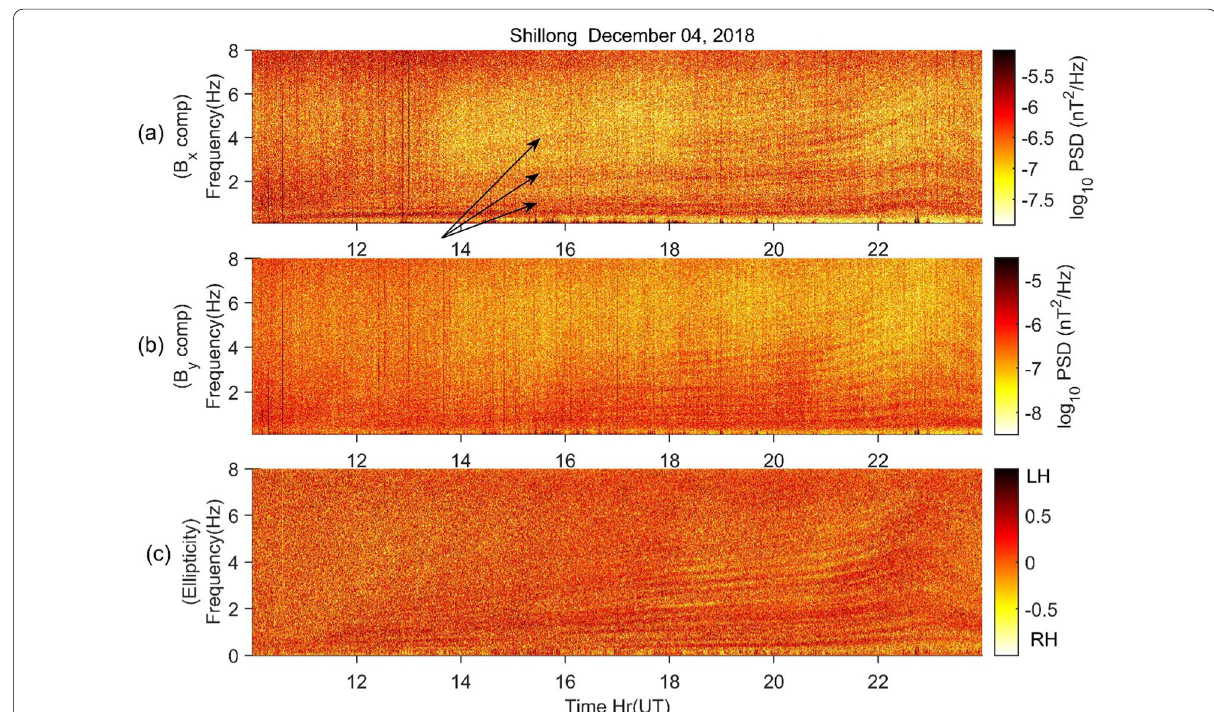
Fig. 2 Dynamic spectra of B x ( a ), B y ( b ) components and ellipticity ( c ), respectively, demonstrating the presence of double spectral resonance structures IAR observed at Shillong on December 04,